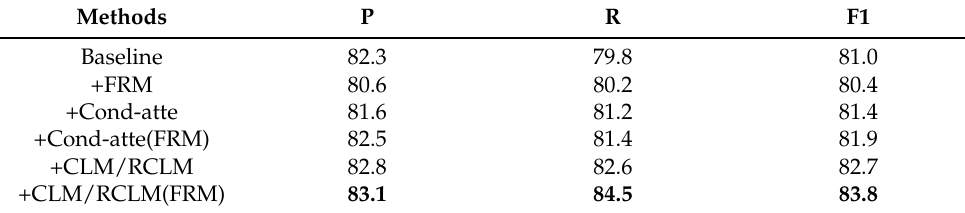
Table 4. The ablation study on